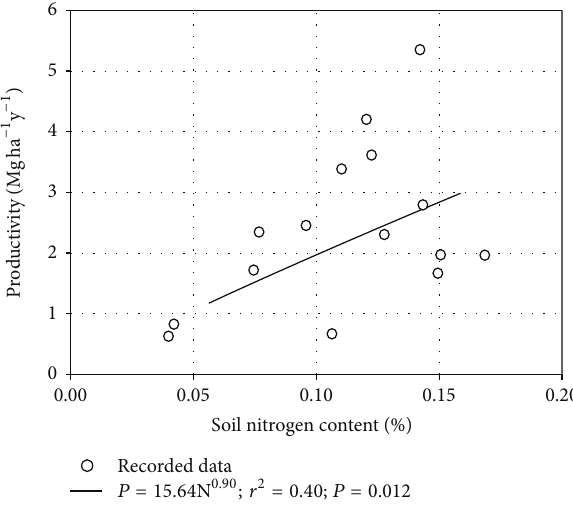
Figure 2: The relationship between aboveground productivity and soil nitrogen content in the Tamaulipan thornscrub forests of northeastern Mexico.